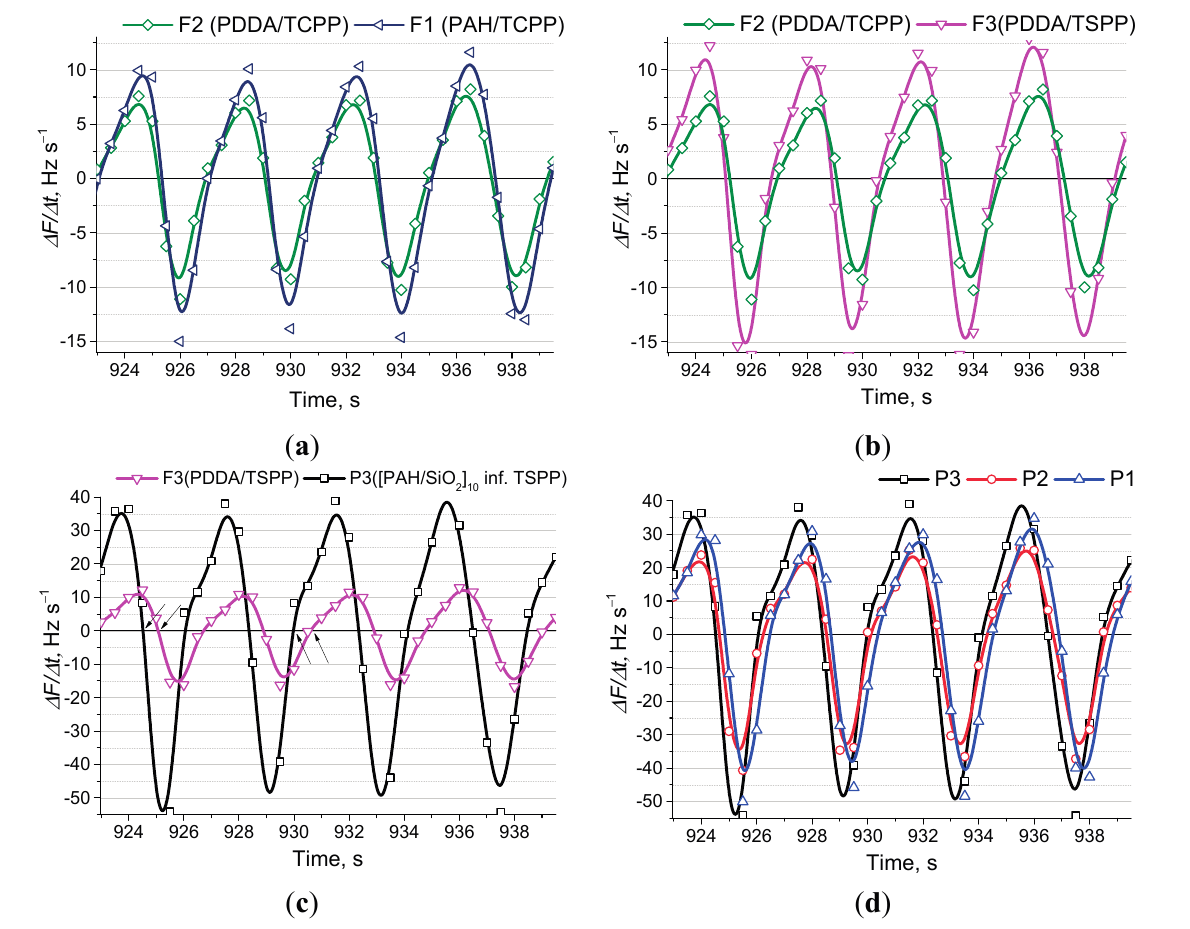
Figure 8. Comparison of the different QCM sensors responses to respiration. ( a ) Influence of the polycation in the PAH/TCPP and PDDA/TCPP coatings; ( b ) Influence of the anionic compound in flat film PDDA/TCPP and PDDA/TSPP coatings; ( c ) Influence of the morphology, flat vs . porous coating with the same sensitive receptor: PAH/TSPP compared to TSPP-infused (PAH/SiO 2 ) 10 coating; ( d ) Influence of the sensitive receptor in the same type porous (PAH/SiO 2 ) 10